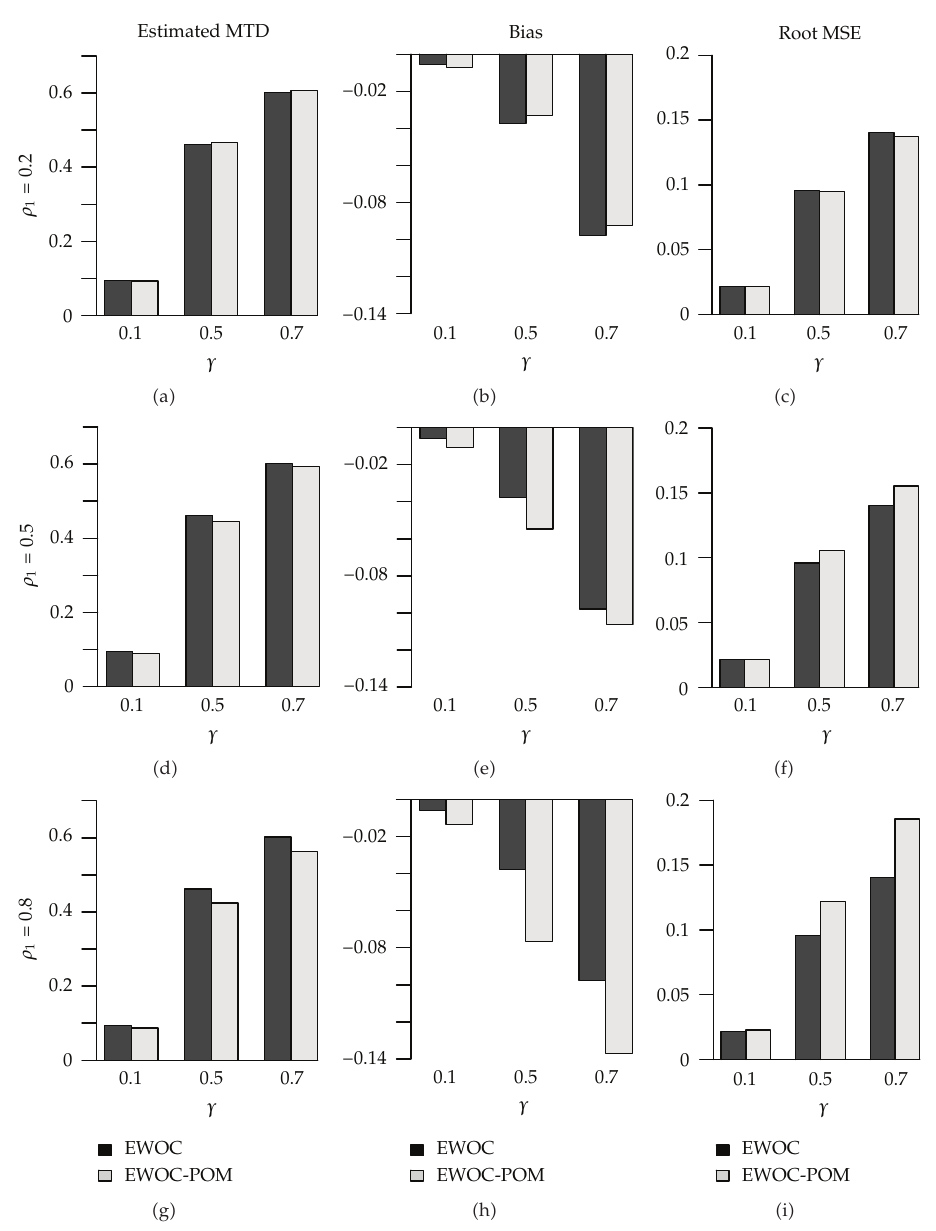
Figure 5: Summary statistics for trial e ffi ciency for EWOC and EWOC-POM under all scenarios. Each graph represents a mean value obtained from all patients from all 1000